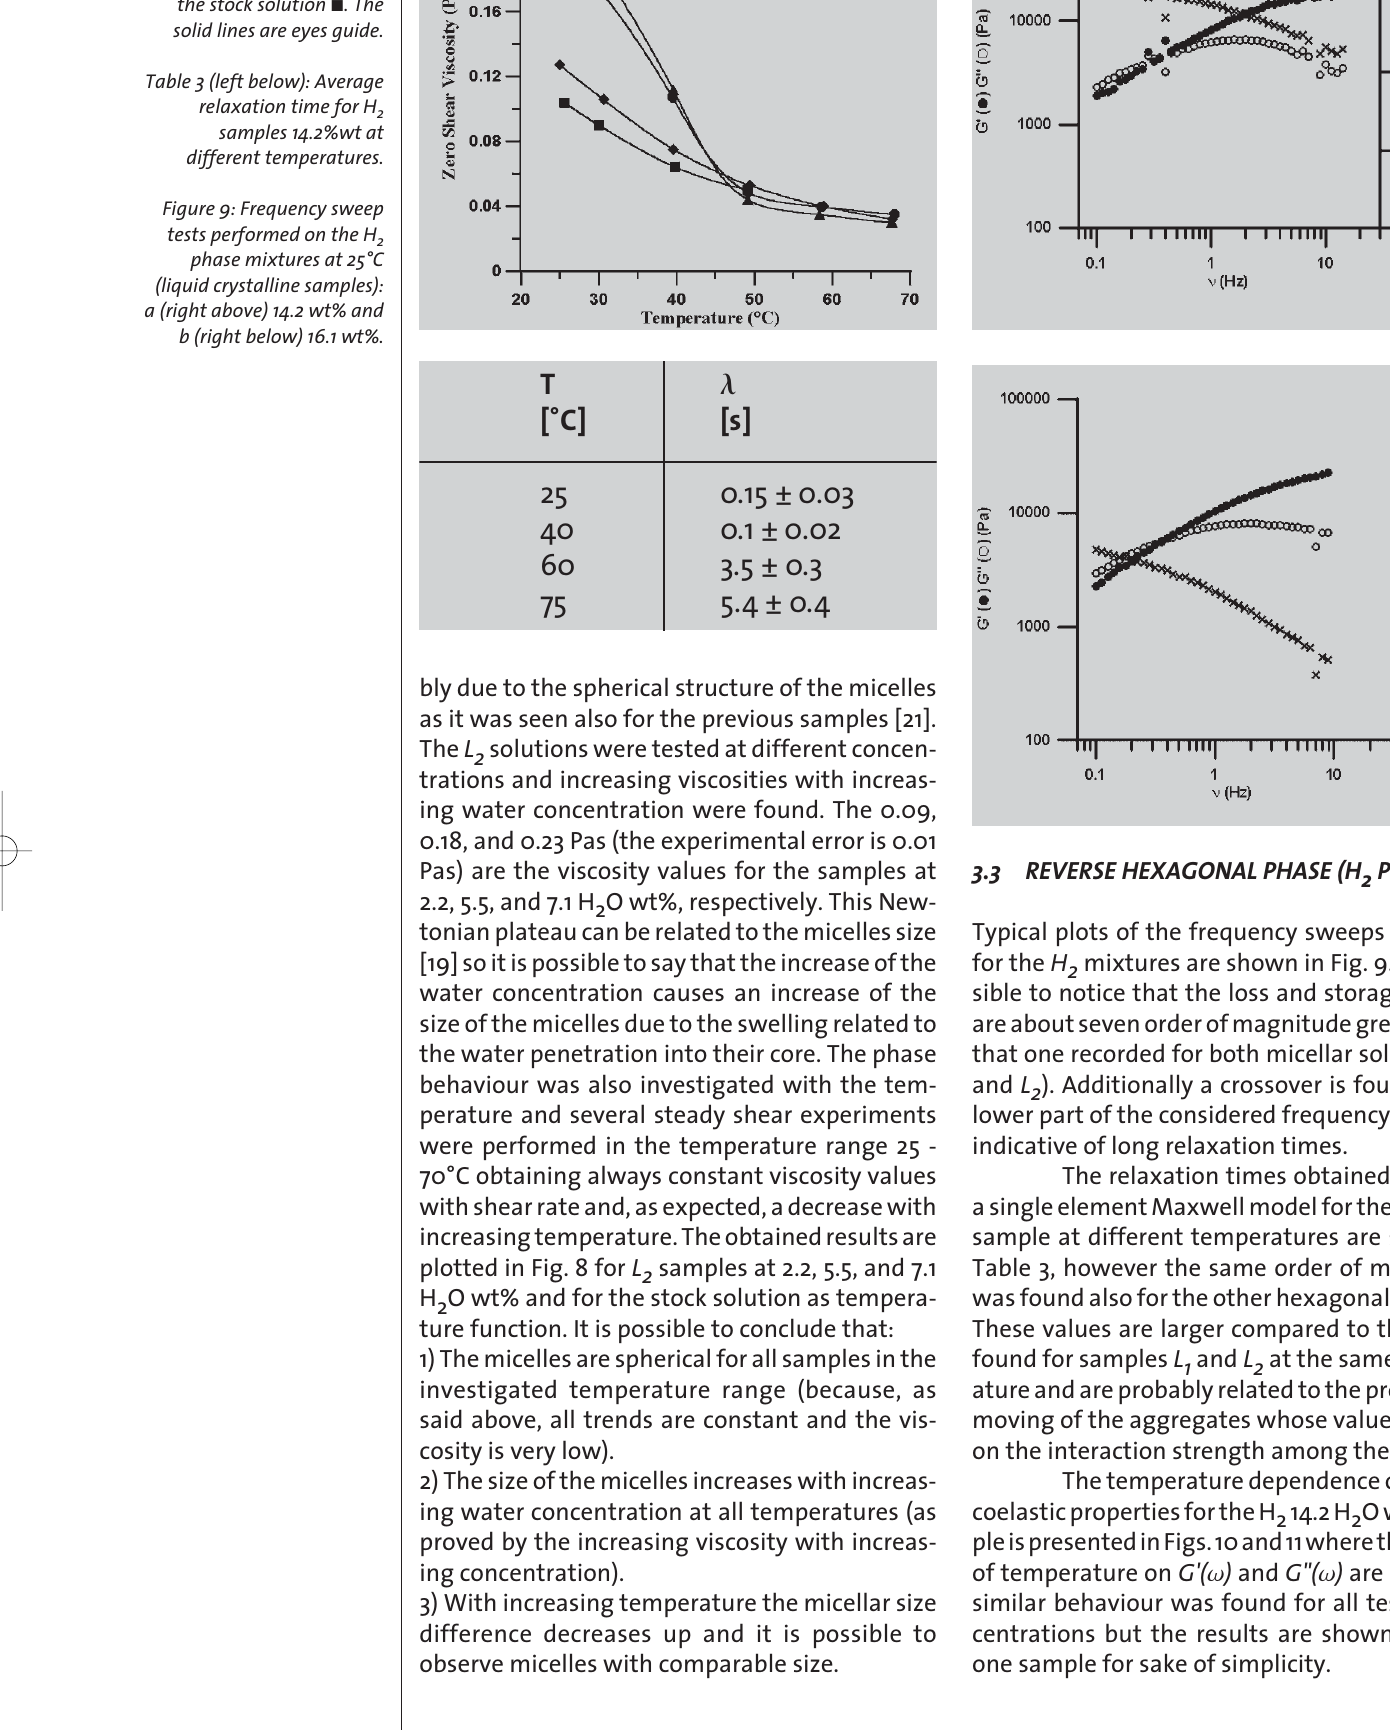
Figure 8 (left above): Zero shear viscosity versus tem- perature for selected L 2 samples: Ï 2.2 wt%, Ê 5.5 wt%, Ú 7.1 wt% and for the stock solution ‡ . The solid lines are eyes guide. Table 3 (left below): Average relaxation time for H 2 samples 14.2%wt at different temperatures. Figure 9: Frequency sweep tests performed on the H 2 phase mixtures at 25°C (liquid crystalline samples): a (right above) 14.2 wt% and b (right below) 16.1